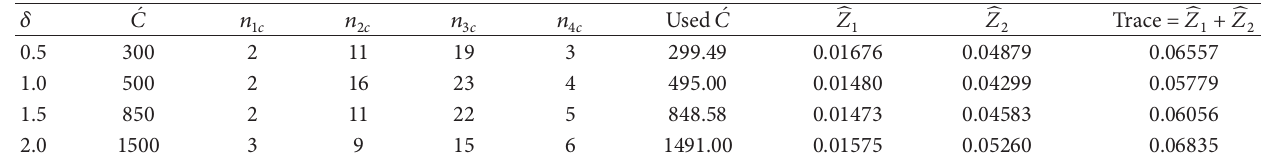
Table 6: Proposed compromise allocation.